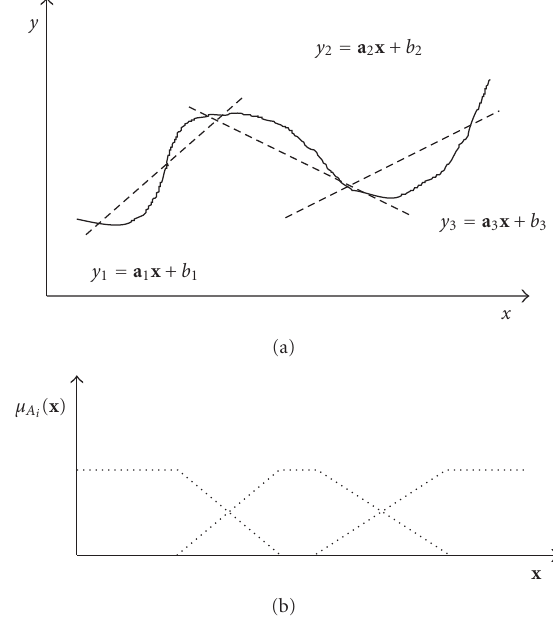
Figure 3: Fuzzy model